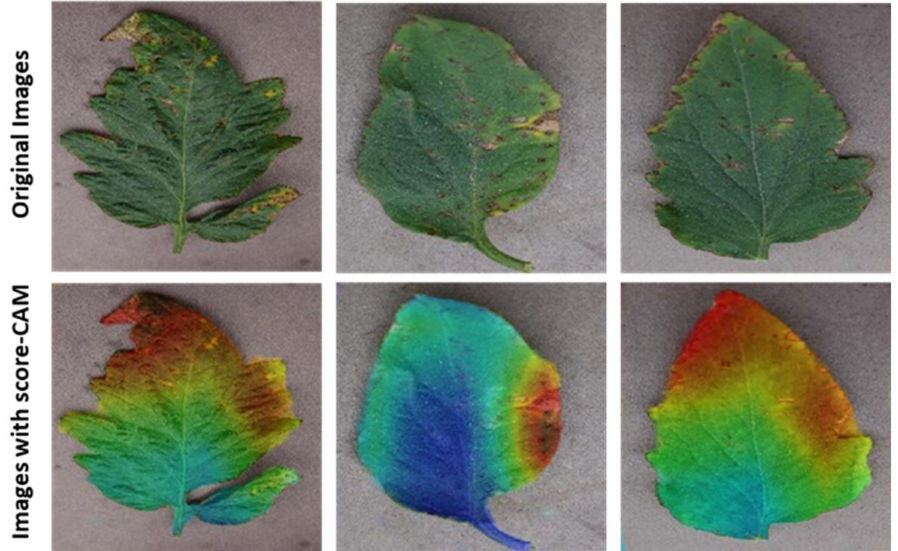
Figure 8. Score-CAM visualization of correctly classified tomato leaf images: Original leaves, score- CAM heat map on segmented leaves.